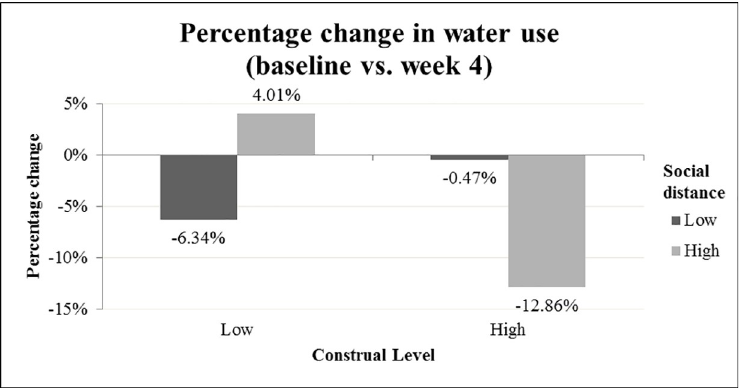
Fig 3. Percentage change in water use relative to control group between baseline (week 0) and week